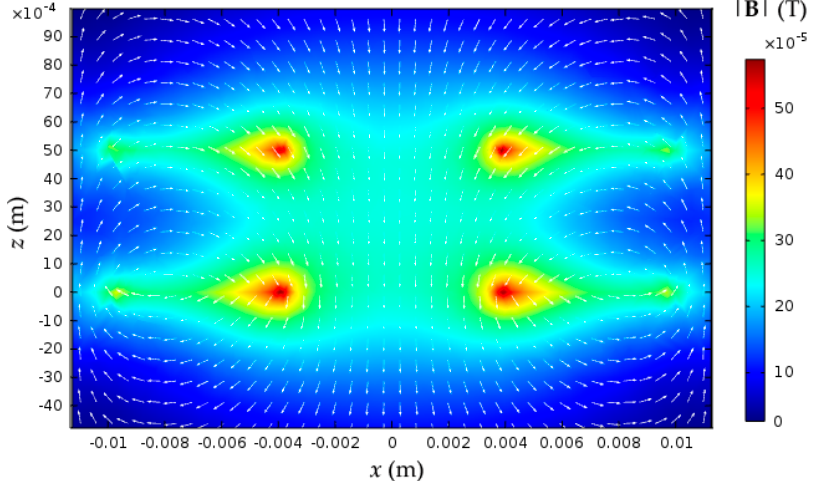
Figure 24. Magnetic flux density distribution (color) and its normalized vectors (white arrows) in xz surface, for the model with maximized efficiency at r = 0.01 m, h = 0.005 m, n = 30, and f = 1 MHz.